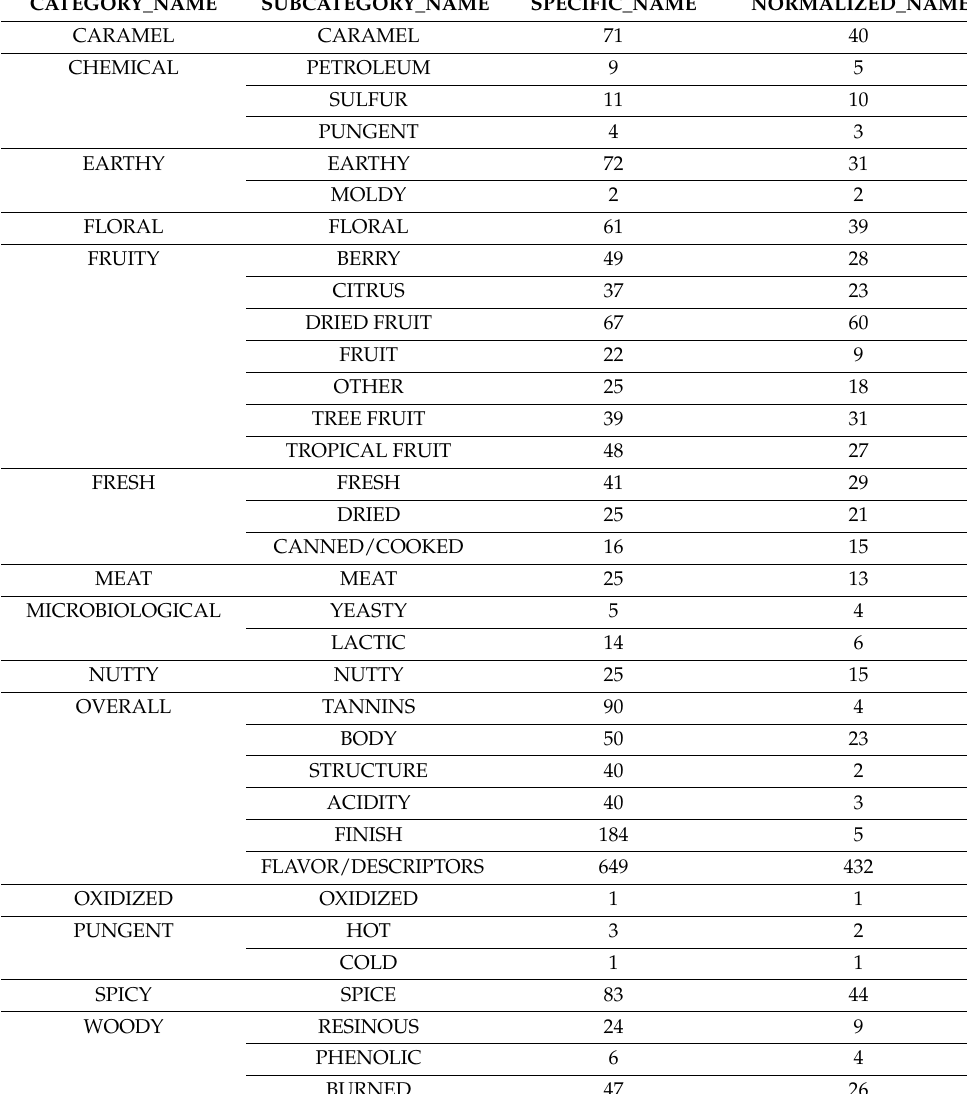
Table 1. Summary of all wine